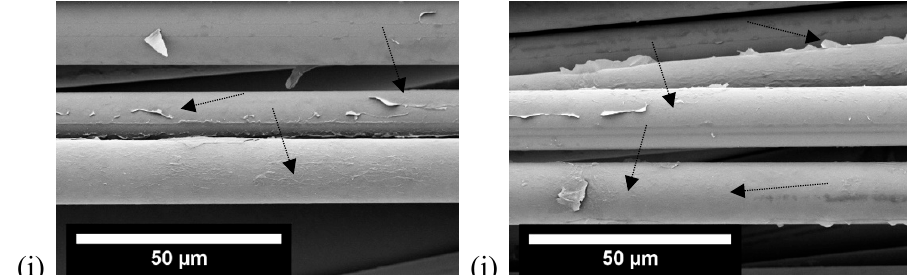
Figure 2. Scanning electron microscopy of ( a ) neat GF and GF-coated by reduced graphene oxide (rGO) under different processing conditions. ( b ) 0A, ( c ) 0B, ( d ) 0C, ( e ) 1A, ( f ) 1B, ( g ) 1C, ( h ) 2A, ( i ) 2B, ( j ) 2C.